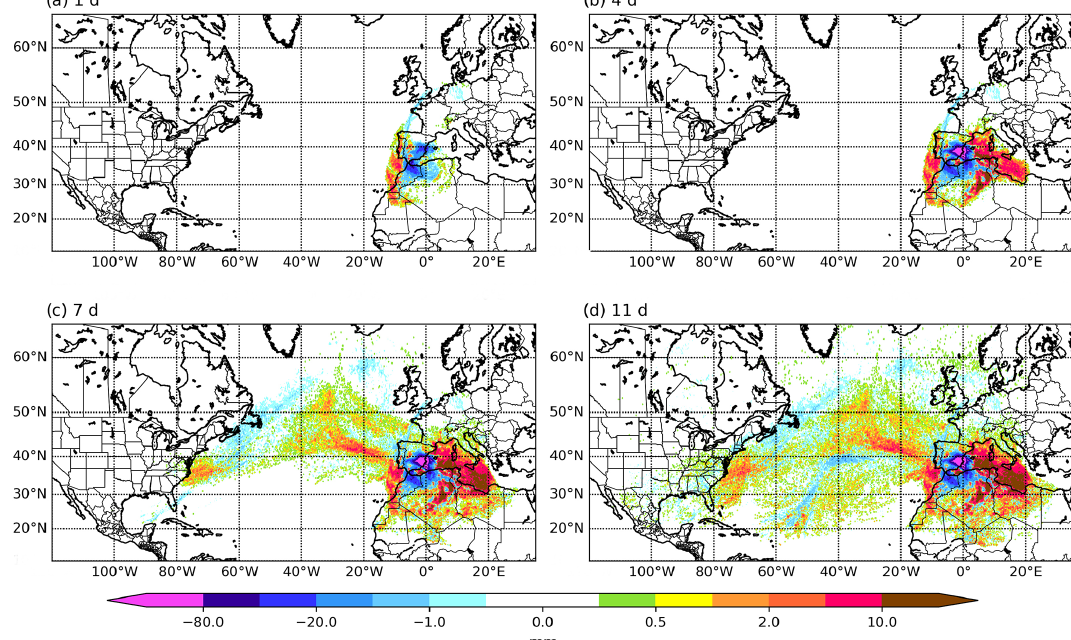
Figure 4. E – P balance evolution back in time for 1 (a) , 4 (b) , 7 (c) and 11d (d) . Particles were selected from 5 ◦ W–1 ◦ E and 37–42 ◦ N for 19 October at 06:00UTC to 21 October at